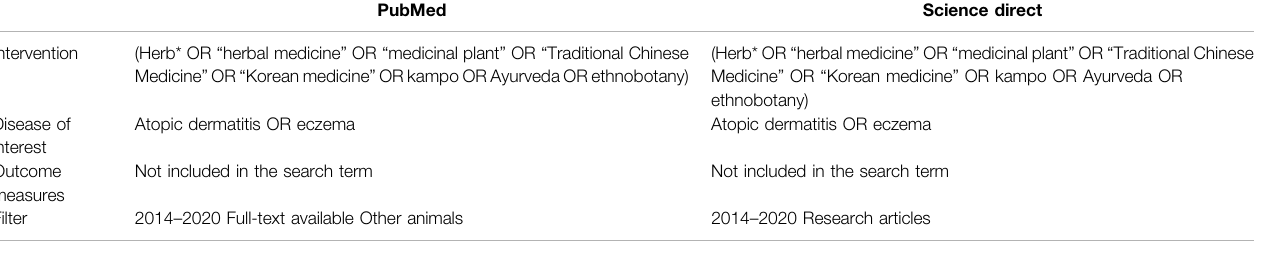
TABLE 1 | Respective search strategies applied for PubMed and Science Direct.